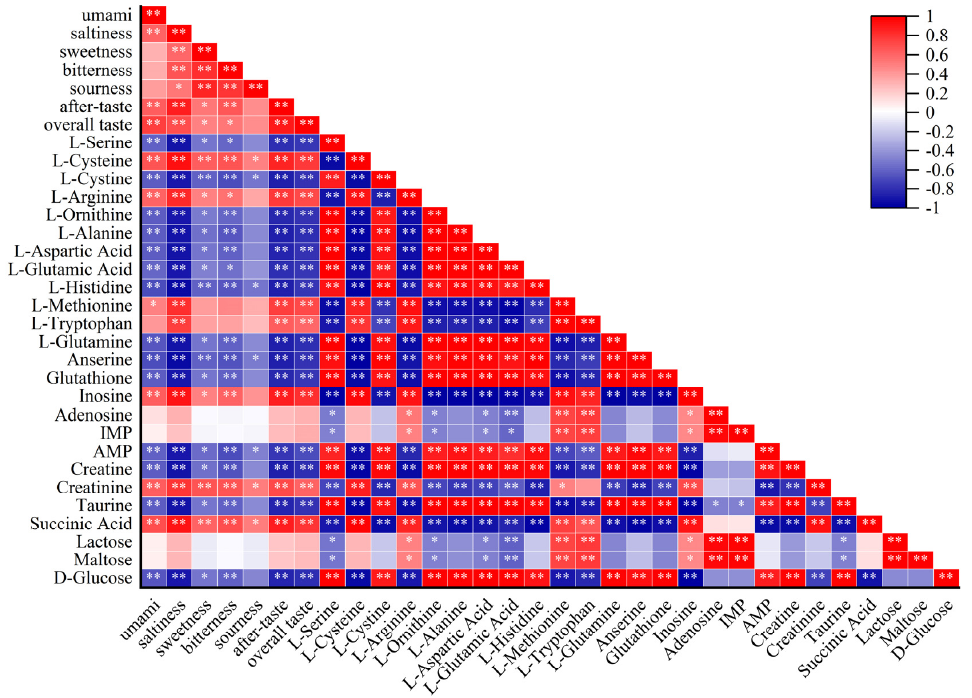
Figure 6. Correlation between sensory assessment and metabolites in dry-cured beef.